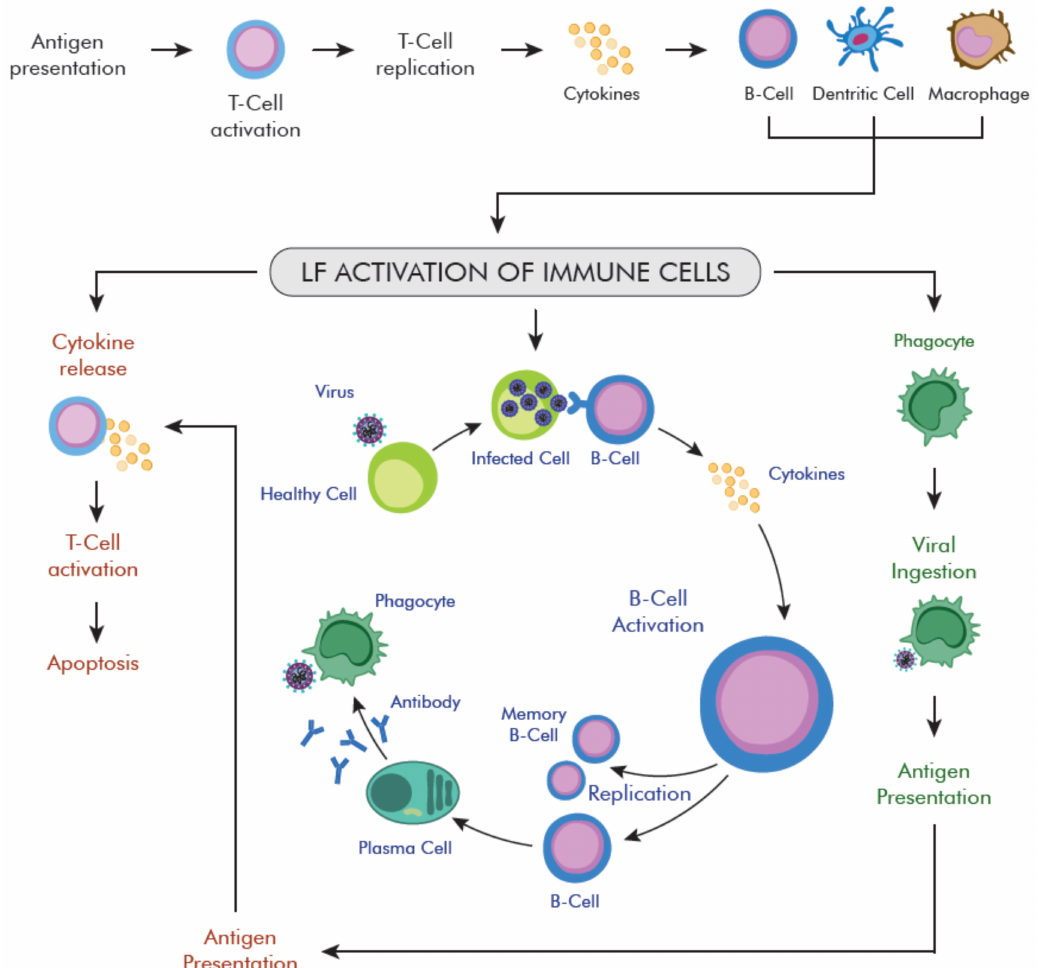
Figure 4. The lactofferin-mediated immune response of anti-viral cells [175]. Main activities and cites of action of lactoferrin (LF) in host defense against viral entry. The diagram illustrates the main effects of lactoferrin on T and B cells, macrophages, and dendritic cells (DC). In the initial stage of a specific immune response, antigen-presenting cells activate naïve T cells, presenting them with antigens and providing additional costimulatory signals. Activated T lymphocytes undergo intensive division and form functionally differentiated subpopulations: Effector T lymphocytes and memory T lymphocytes. Effector T lymphocytes migrate to the site of infection, where they inactivate the pathogens present there, and then die by apoptosis. B-cells capture foreign antigens and presents them to T-cells. Activated B-cells (after antigen binding) transform into antibody secreted plasma cells or memory B-cells. Lactoferrin modulates antigen-presenting cell action, including migration and activation, inactivates cells infected with the virus, activates B cells that destroy infected cells with the participation of T cells. Moreover, LF affects the expression of soluble immune mediators (cytokines, chemokines, and other effector molecules) to regulate inflammatory and immune